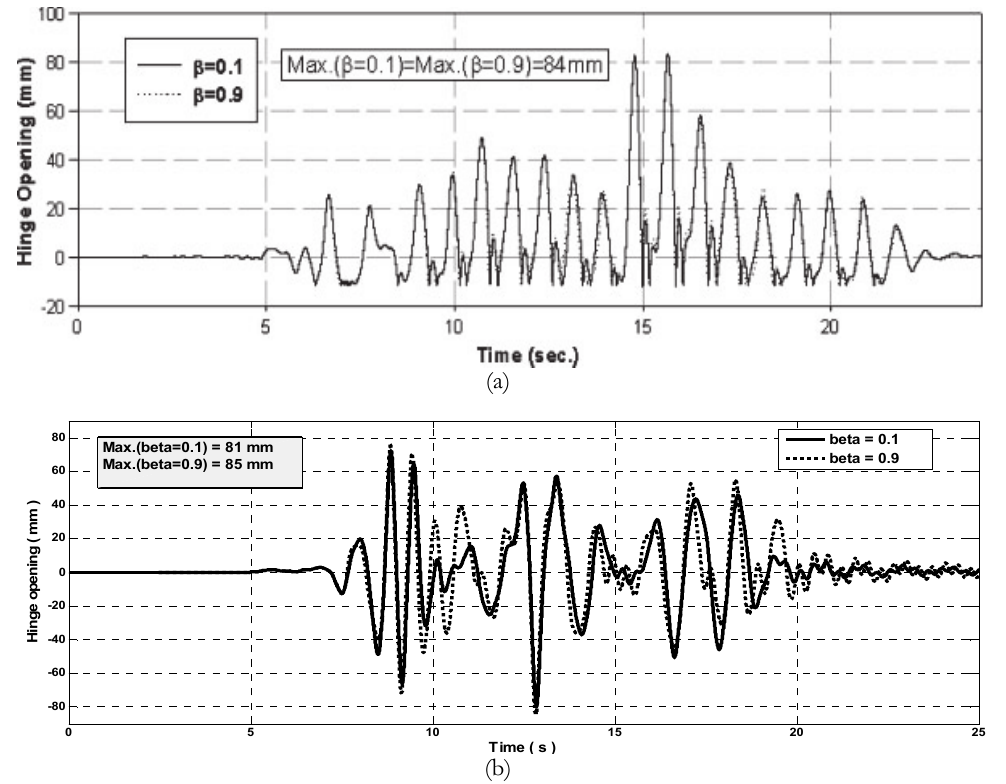
Figure 6: The time histories of the hinge opening when using SMA hysteresis with thick hysteresis ( β =0.1) and narrow hysteresis ( β =0.9) under the scaled 1989 Loma Prieta, (a) Andrawes study [17]; (b) Numerical results in this study using MATLAB. Seismic Efficiency of SMA at Bridge Joints